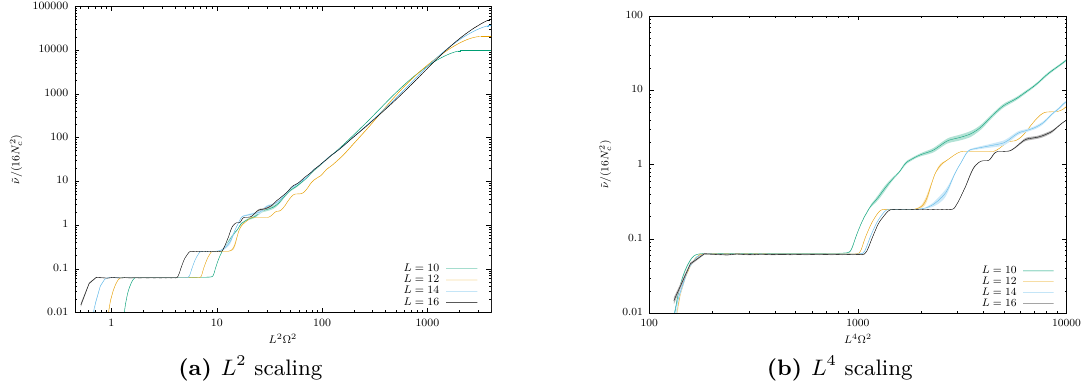
Figure 12. Scaling of the N c = 2 normalized mode number with the lattice volume L at λ lat = 0 . 5 . For an intermediate range of Ω 2 the results are consistent with L 2 scaling, whereas the lowest modes scale like L 4 .